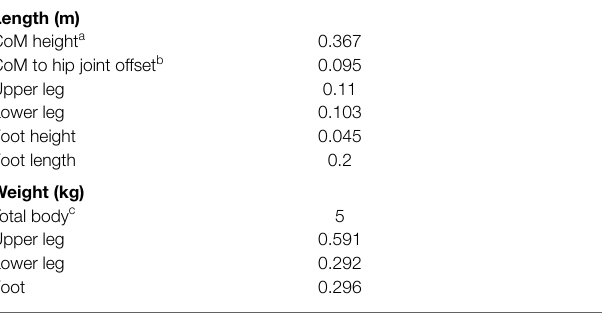
TABLE 1 | Humanoid robot parameters used in the simulations